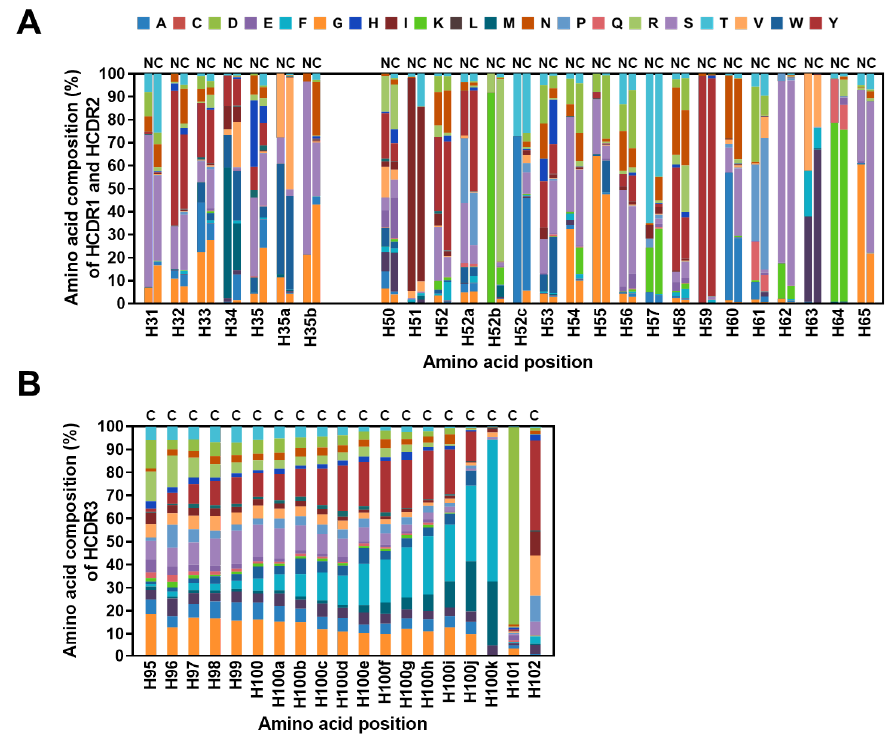
Figure 6. Diversity of the amino acid composition in the heavy chain complementarity-determining regions (HCDRs) of the constructed library. ( A ) The amino acid compositions at each position within HCDR1 and HCDR2 of natural human antibodies (N) and in the constructed library (C) were comparatively analyzed. The frequencies of amino acids occurring in each position of HCDR1 and HCDR2 ( A ) were compared with those in the reference sequences and are shown as percentages and represented in each stacked bar with designated colors. ( B ) Similarly, the amino acid composition of HCDR3 was analyzed and expressed as a percentage and represented in each stacked bar with designated colors. The x axis shows the amino acid position based on Kabat numbering.